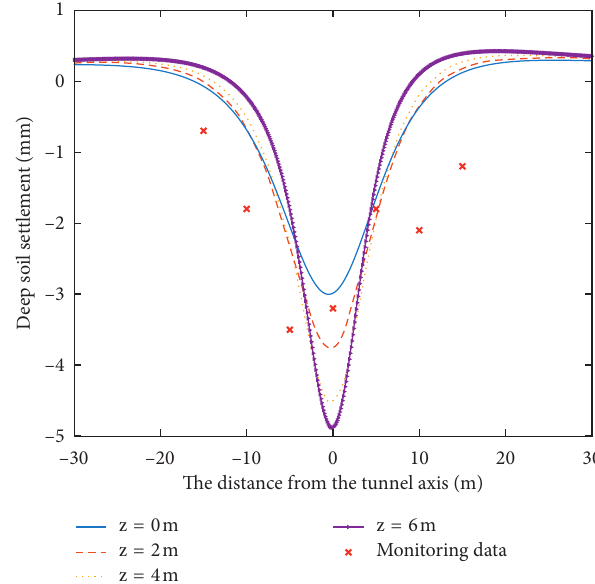
Figure 8: Longitudinal profiles of displacement due to different factors.